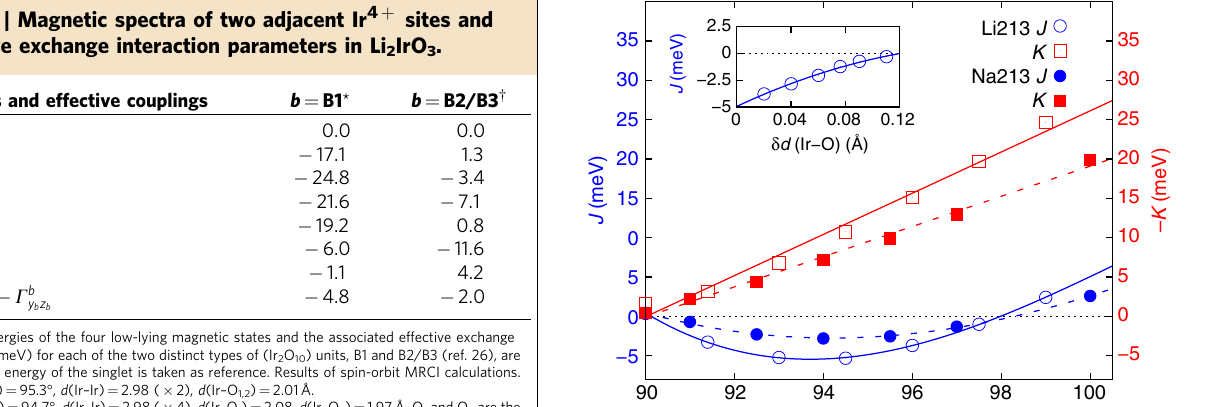
Fig. 1d. This asymmetry reflects the constitutive difference between bonds B1 and B2/B3. Finally, there is also an effective longer range exchange driven by the J 3 interaction in the original hexagonal model.